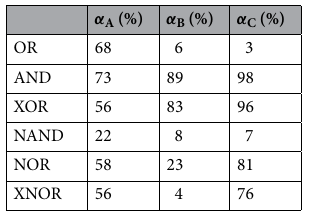
Table 1. The coupling ratio of the directional coupler DC A , DC B and DC C .